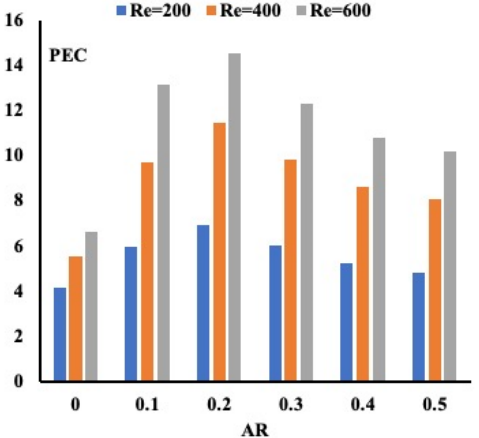
Figure 9. Performance evaluation criterion for all cases.